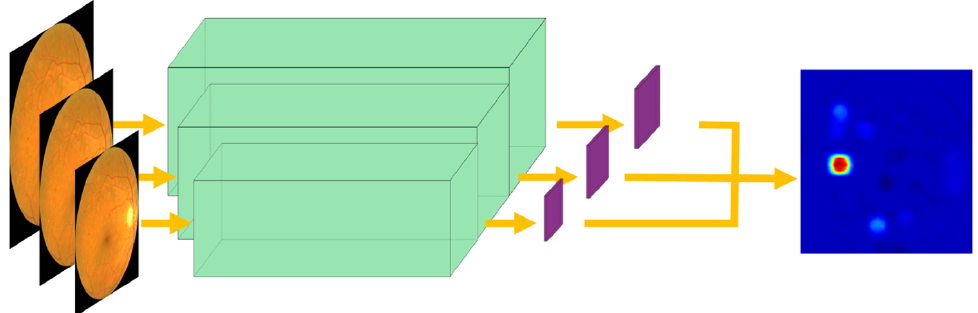
Figure 3. Multiscale activation map extraction. Three activation maps are extracted at different scales and combined to form an accurate result.